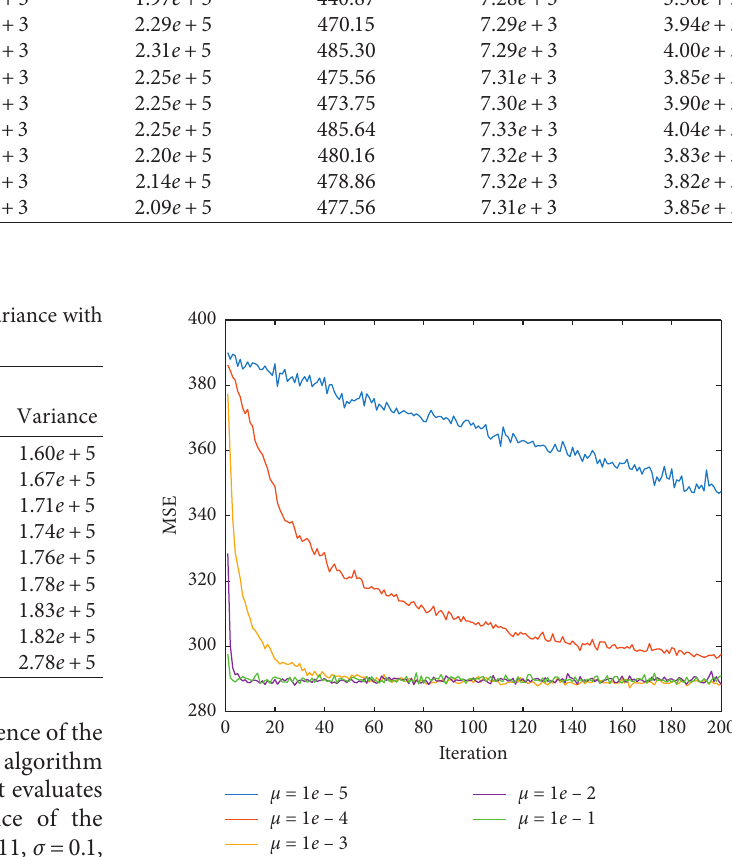
Figure 13: Evolution of MSE for different learning parameters μ